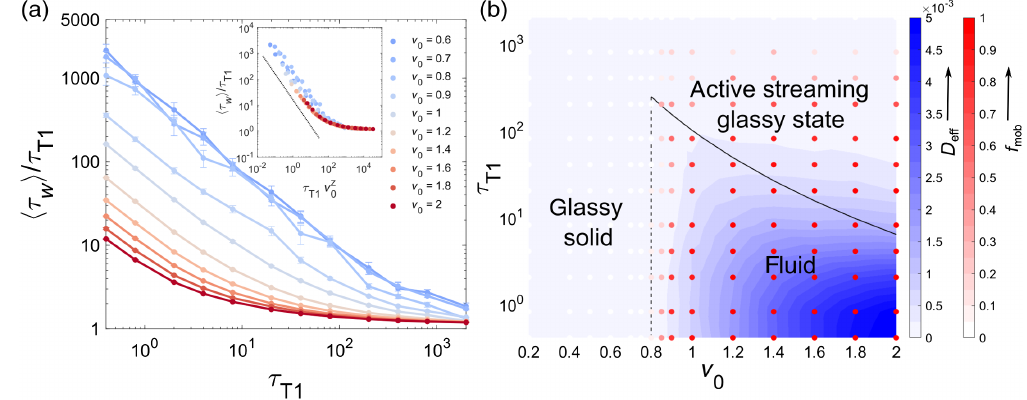
FIG. 3. Universal scaling of waiting times and phase diagram of cell dynamics. (a) Mean waiting times, scaled by τ function of τ at different v 0 . Inset: scaling collapse of h τ w i = τ T 1 black dotted line is a guideline for the power law of x − 1 . (b) The phase diagram on the v 0 − τ cell dynamics along with approximate phase boundaries. The black dotted line represents an approximate boundary between the glassy solid and the fluid phase. The black solid line is the phase boundary predicted by the crossover scaling function given by Eq. (5). The heat map represents the values of effective diffusivity D values of f , the fraction of mobile cells with net displacements of at least two cell mob